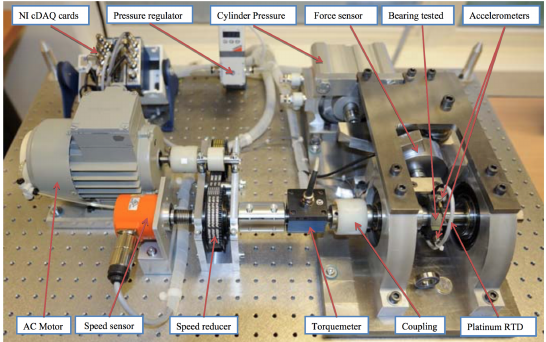
Figure 5. PRONOSTIA experimental